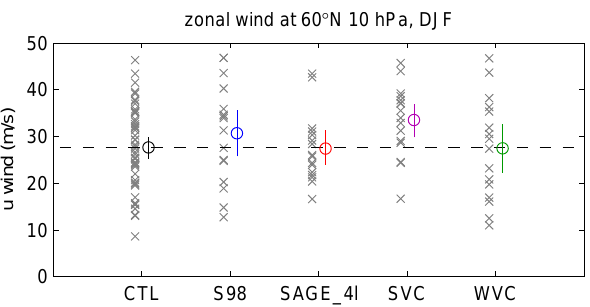
Figure 9. DJF zonal wind at 60 ◦ N and 10hPa for the CTL ensem- ble and the volcanically forced ensembles S98, SAGE_4 λ , SVC and WVC. Individual ensemble members shown as grey symbols. En- semble means shown in coloured symbols, with vertical whiskers representing the 95% confidence interval of the ensemble mean. Dashed horizontal line shows the ensemble mean of the CTL en-